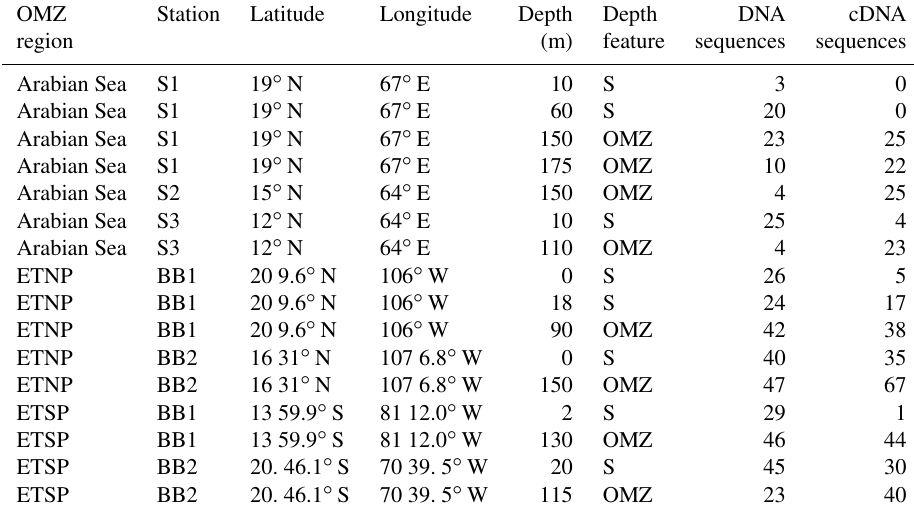
Table 1. Sample and clone library descriptions. Sampling regions and depths as well as sequences derived from each depth. S refers to surface (within the euphotic zone); OMZ refers to the oxycline or core of the OMZ, all below the euphotic zone. OMZ Station